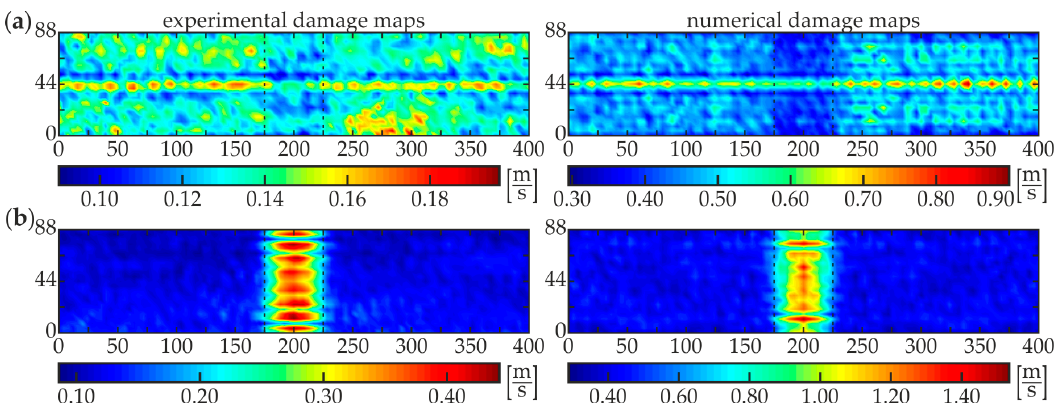
Figure 10. Experimental and numerical WRMS damage maps for specimen #2: ( a ) excitation P3 and ( b ) excitation P4.